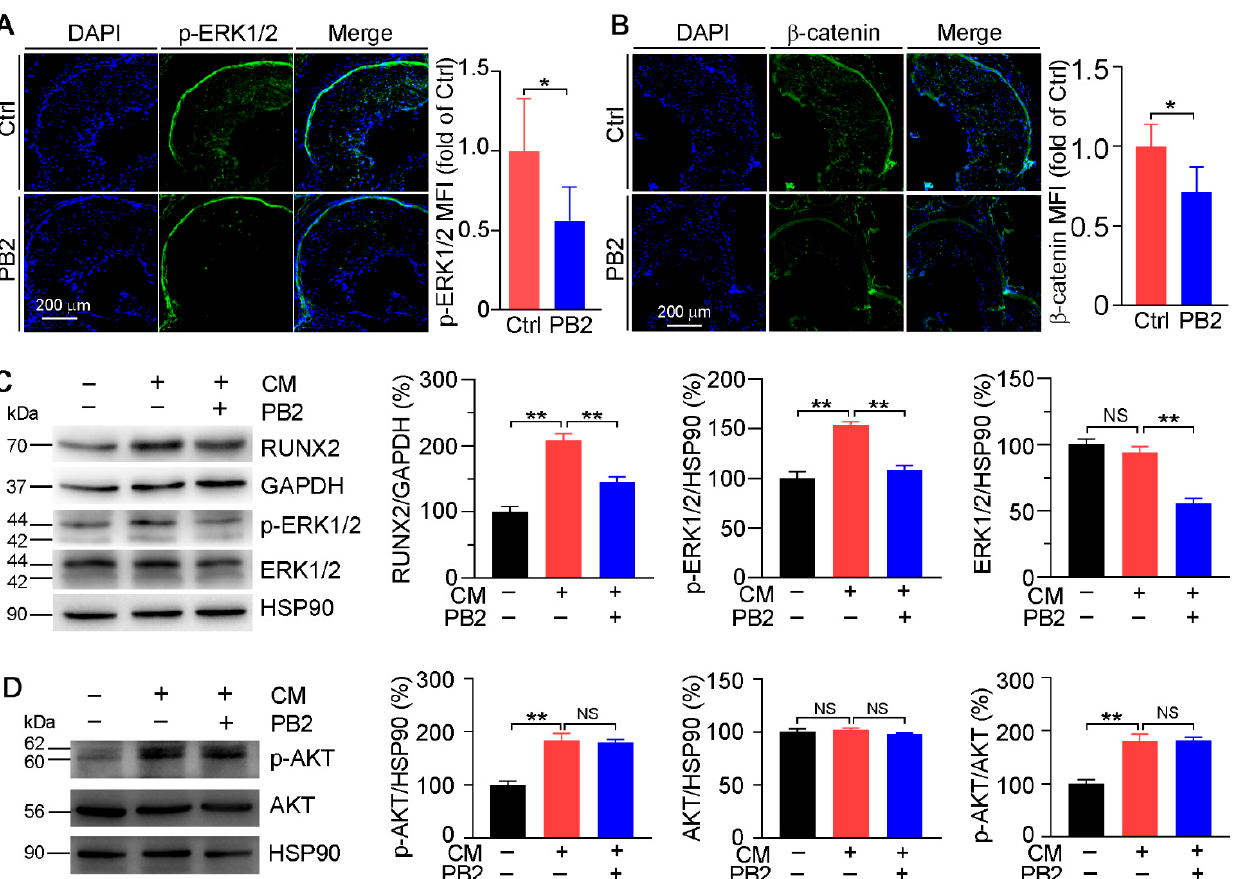
Figure 6. Procyanidin B2 inhibits ERK1/2 activation in vitro and in vivo. The expression of phosphorylated ERK1/2 (p-ERK1/2 ( A ) and β -catenin ( B ) in aortic root cross sections of apoE − / − mice was determined by immunofluorescent staining with the quantification of MFI. * p < 0.05 (7 mice per group were used, and at least three samples from each mouse were taken as technical replicates). HASMCs were cultured in a normal medium, CM, or CM plus PB2 (2 µ M) for 1 week. The expression of RUNX2, p-ERK1/2, and ERK1/2 ( C ), as well as p-AKT and AKT ( D ), was determined by Western blot with the quantitative analysis of band density or ratio of p ‐ AKT to AKT. ** p < 0.01, NS: not significant ( n = 3).